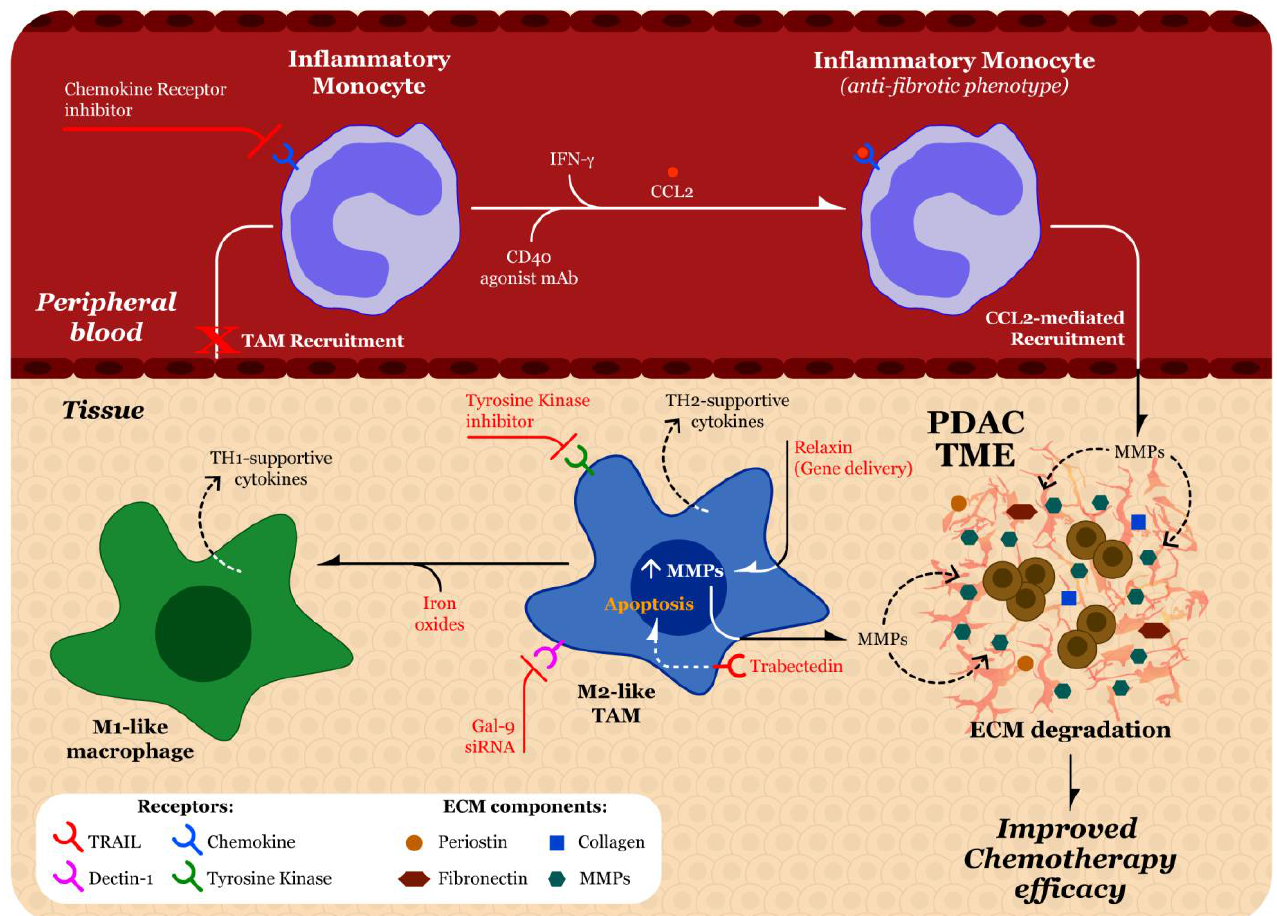
Figure 4. Potential tumor associated macrophage (TAM) targeting strategies. Strategies have been developed that target macrophages in the peripheral blood (top panel) and the PDAC TME (bottom panel). Inhibition of the chemokine receptor may decrease recruitment of inflammatory monocytes into the tissue, where they can polarize into M2-like TAMs. Treatment with a CD40 agonist monoclonal antibody (mAb) can increase systemic levels of interferon-γ (IFN-γ), thereby polarizing the inflammatory monocyte into an anti-fibrotic phenotype. The binding of CCL2 then recruits the inflammatory monocyte into the tissue, where it releases various matrix metalloproteinases (MMPs) that can degrade the abundant extracellular matrix (ECM) of the pancreatic ductal adenocarcinoma tumor microenvironment (PDAC TME), improving chemotherapy efficacy. In general, M1-like macrophages tend to release TH1-supportive cytokines, which are considered more protective against cancer cells. M2-like TAMs usually release TH2-supportive cytokines, which tend to support cancer progression. The literature describes a variety of methods (noted in red text) to target M2-like TAMs. Inhibition of the tyrosine kinase receptor may reduce survival and proliferation of M2-like TAMs. Both iron oxides and targeting of the dectin-1 receptor by galectin-9 small interfering RNA (siRNA) can repolarize M2-like TAMs into the M1-like phenotype. Trabectedin operates through the TNF-related apoptosis-inducing ligand (TRAIL) receptor, thereby leading to apoptosis of the M2-like TAM or switching their secretion profile to that of an inflammatory phenotype. Gene delivery of relaxin (RLN) can upregulate MMP9 and MMP13 genes, thereby leading to increased release of MMPs into the PDAC TME that can degrade fibrosis and improve chemotherapy efficacy.